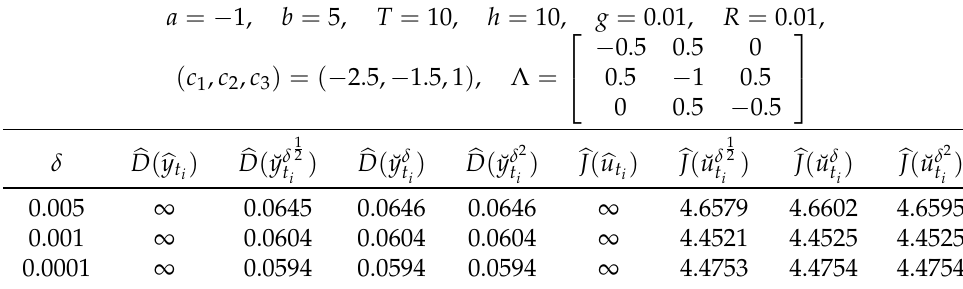
Table 8. The stabilization of the unstable system.